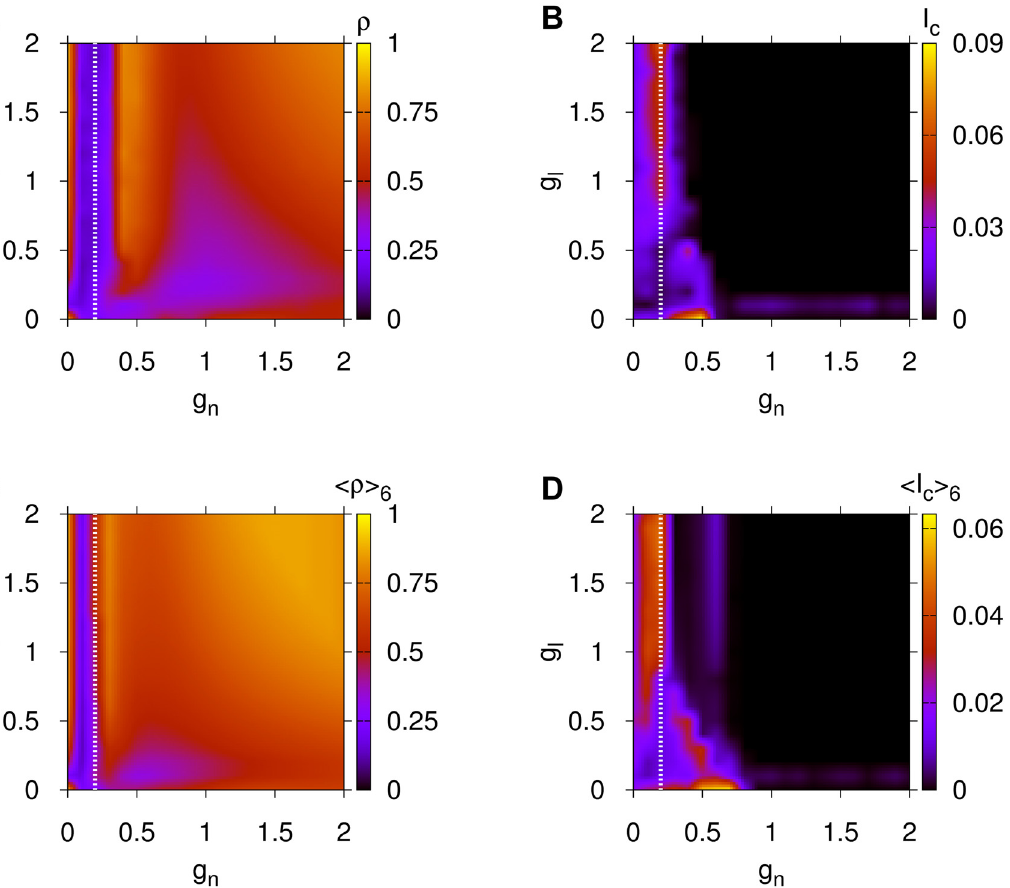
Fig 1. Results for the global synchronization and information flow capacity properties for the C.elegans and averaged human BDNs. Parameter space for the global synchronization ρ in panel (A) and for the upper bound for MIR, I c , in panel (B) for the C.elegans BDN. Panels (C) and (D) are similar but for the averaged global synchronization h ρ i 6 and averaged upper bound for MIR, h I c i 6 for the six human BDNs. Here, g n is the chemical and g l the electrical coupling of Eq (2). The regions between the left vertical axes and white dotted lines are replotted in Fig 2 in a finer